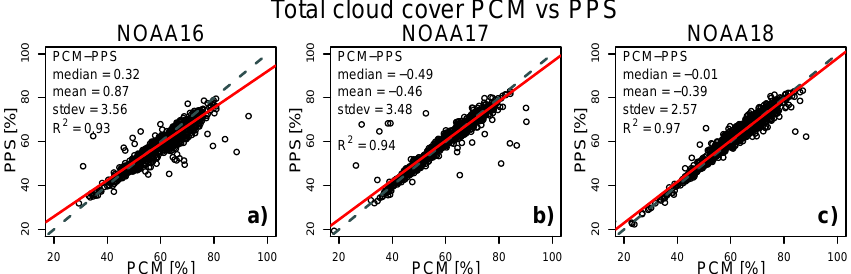
Fig. 6. Scatter plots of the total cloud cover estimates computed over each of the NOAA16, 17 and 18 satellites scenes separately for the PCM and PPS algorithms. Red line denotes linear trend between these two data sets. Some statistics of the PCM–PPS total cloud cover differences distribution are reported. For details see Sect. 4.1.